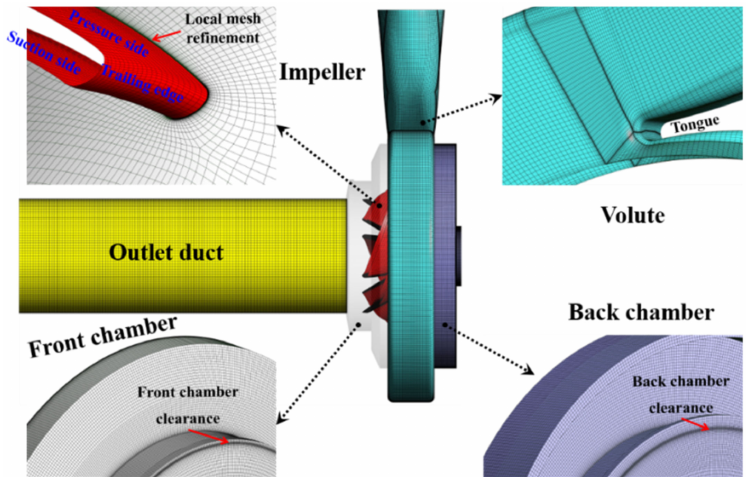
Figure 3. Grids of computational domains.